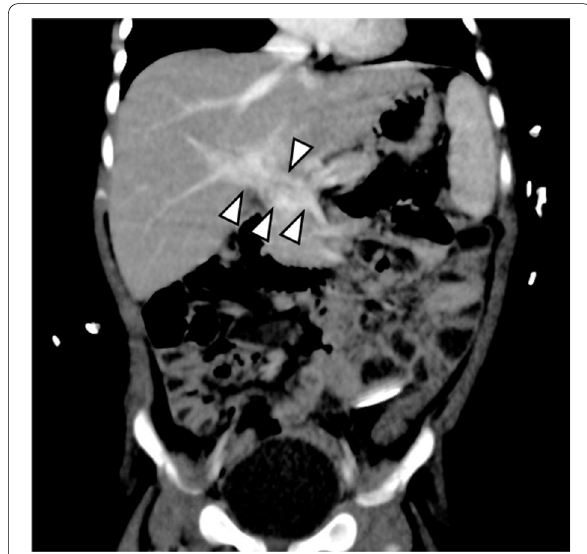
Fig. 4 Contrast-enhanced computed tomography obtained at